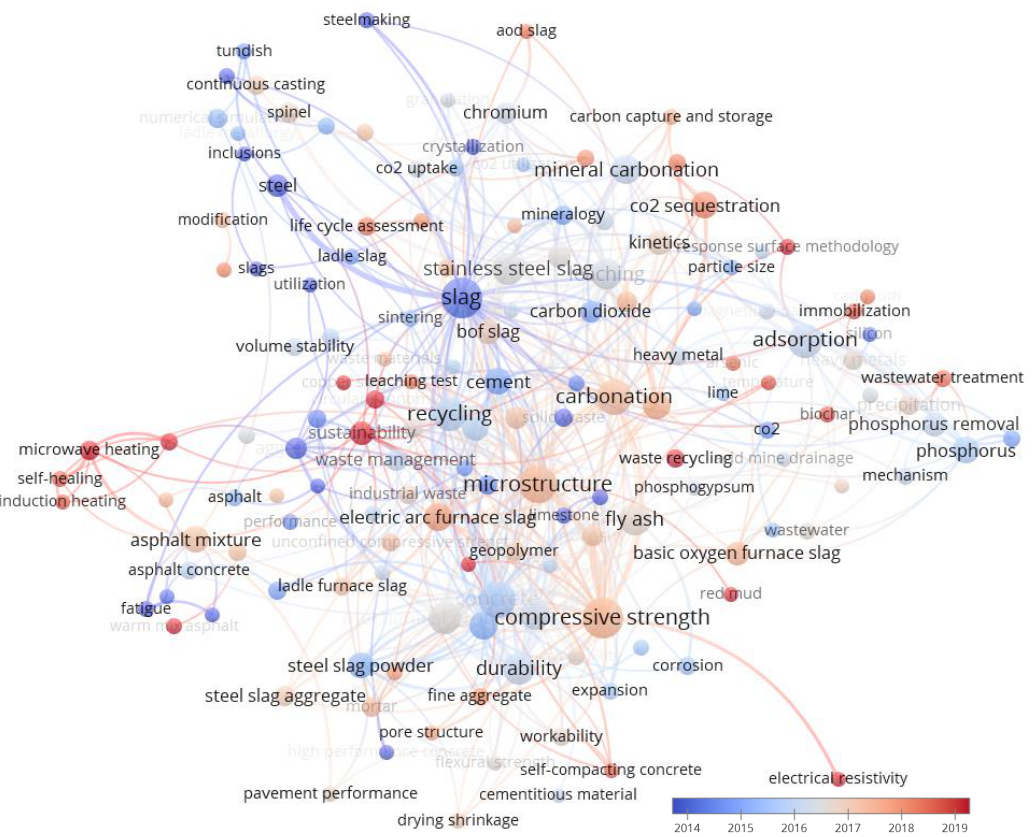
Figure 11. The keywords co-occurrences network with average publication time.